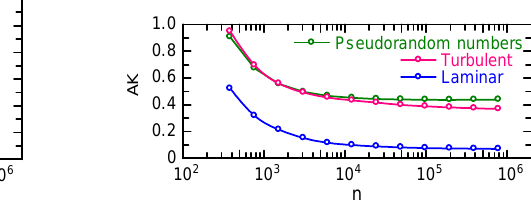
Fig. 3 Distribution of NCD between different Fig. 4 Distribution of AK as a function of data as a function of data length. data